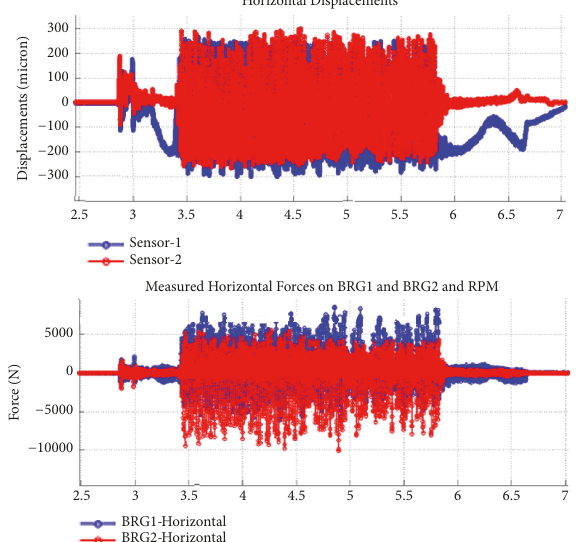
Figure 34: Experimental horizontal displacements and forces at DE (blu line) and NDE (red line) rotor nodes.